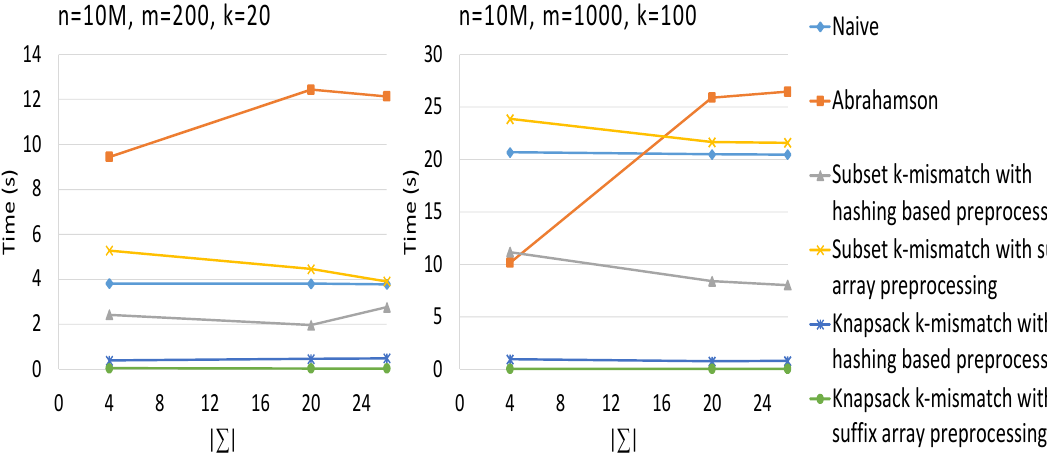
Figure 4. Run times for pattern matching when the size of the alphabet varies from four (DNA) to 20 (protein) to 26 (English). The length of the text is n = 10 millions. The length of the pattern is m = 200 in the first graph and m = 1000 in the second. The maximum number of mismatches allowed is k = 20 in the first graph and k = 100 in the